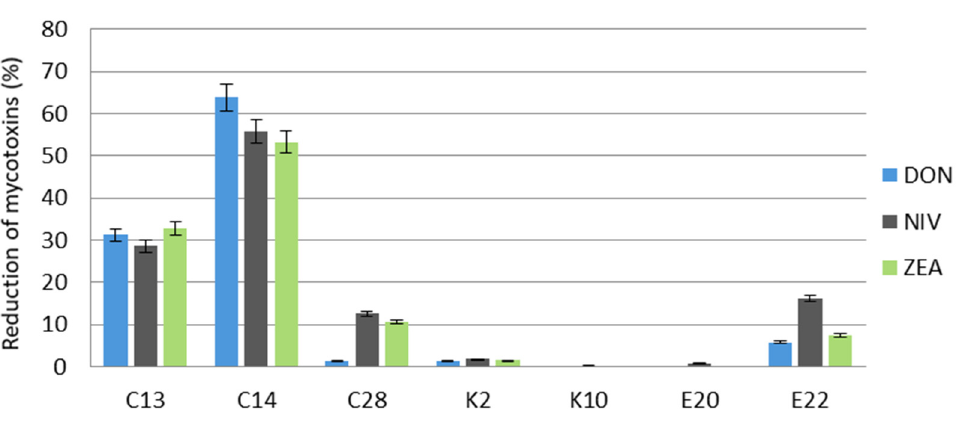
Figure 1. Reduction of deoxynivalenol, nivalenol, and zearalenone produced by F. culmorum in wheat grain after a 14-day incubation with the test yeasts. C13, C14, C28, K2, K10, E20, E22—code numbers of the yeast species acc. to Table 1. Error bar represents the standard error. Table 2. Mycotoxin contents in wheat grain after 14 days of incubation (28 ◦ C) of F. graminearum with the test